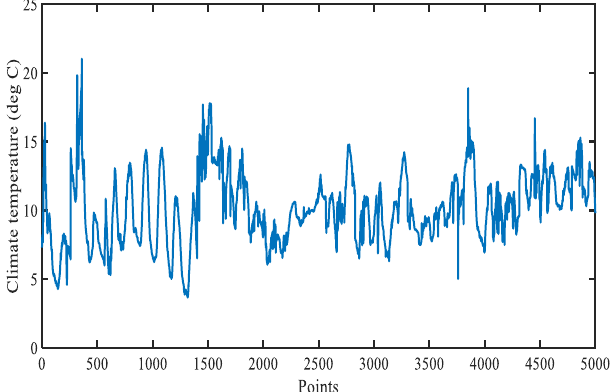
Figure 14. Actual power generation of the wind turbine.